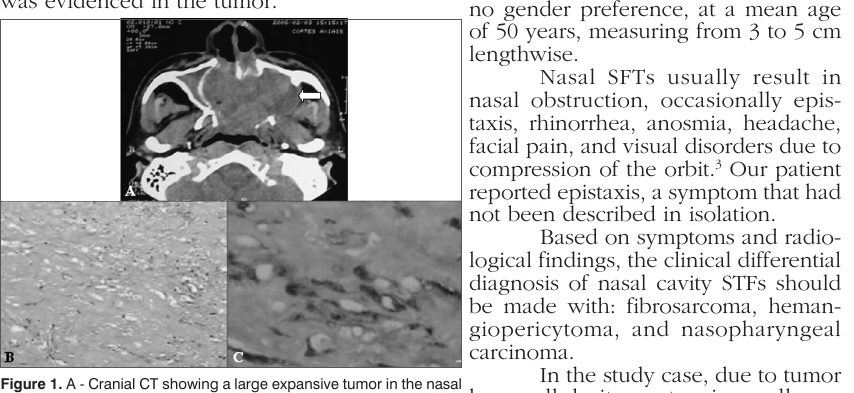
Figure 1. A - Cranial CT showing a large expansive tumor in the nasal fossa (arrow). B - Photomicroscopy showing a fusocellular and colla- genic neoplasm with vascular areas (hematoxylin-eosin stained, 100x magnification). C - Immunohistochemistry showing positive neoplastic cells for the CD34 marker (400x